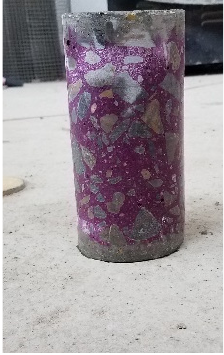
Figure 4. Concrete core sample sprayed with 1% alcohol phenolphthalein solution to measure carbonation depth.